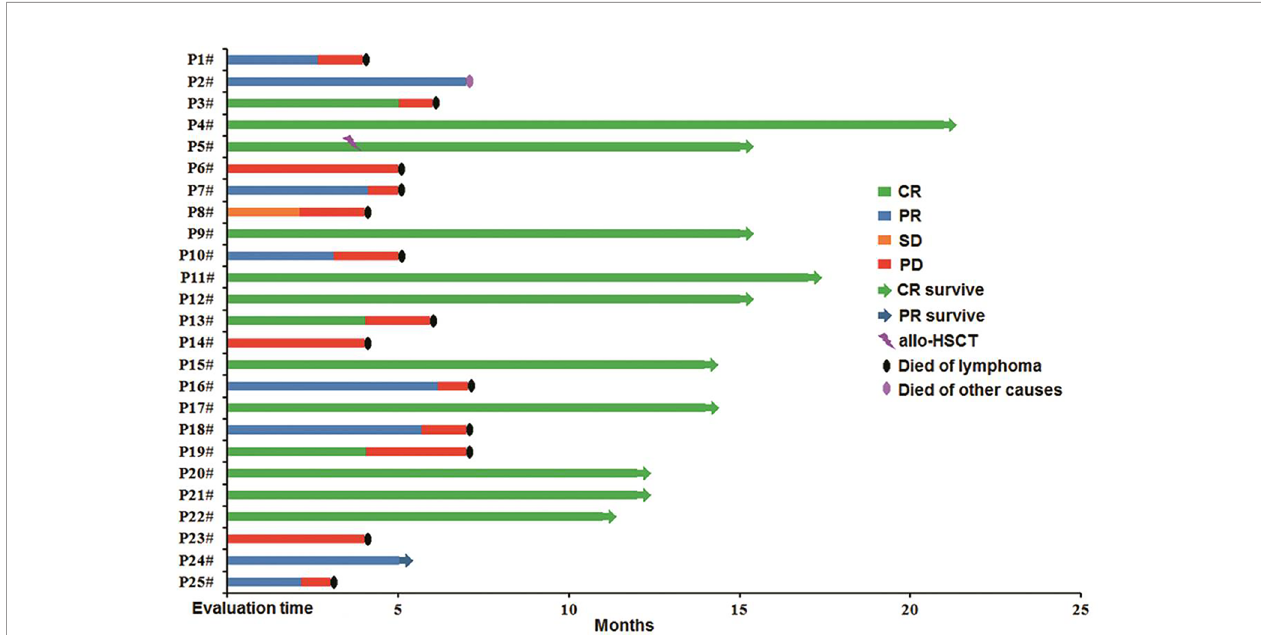
FIGURE 5 | Follow-up of patients in the combined group. P4 # , P5 # , P9 # , P11 # , P12 # , P15 # , P17 # , P20 # , P21 # , and P22 # maintained CR, and allo-HSCT was carried out in P5 # ; P24 # maintained PR; P1 # , P3 # , P6 # , P7 # , P8 # , P10 # , P13 # , P14 # , P16 # , P18 # , P19 # , P23 # , and P25 # died of the original disease, P2 # died of other factors. HSCT, hematopoietic stem cell